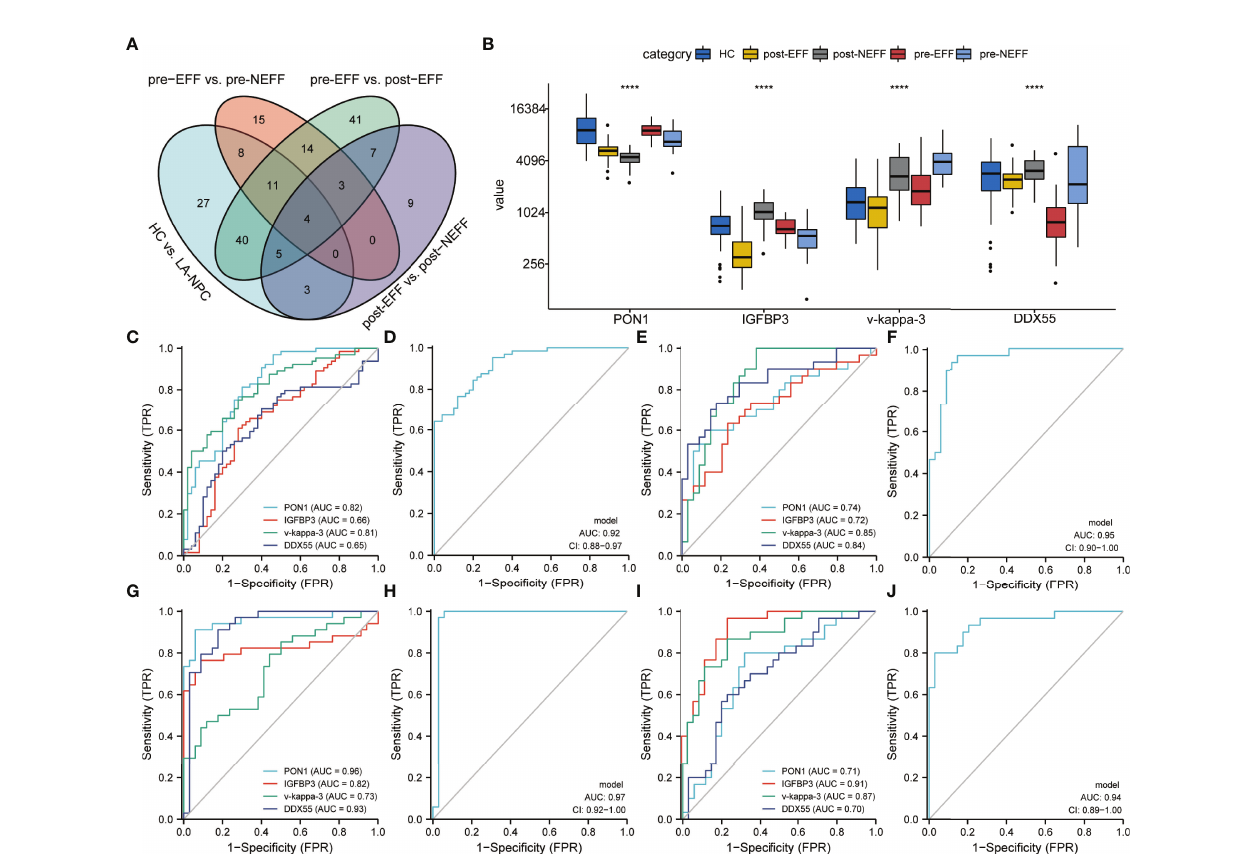
FIGURE 9 | Identi fi cation of candidate biomarkers. (A) Venn diagram showing the overlap of DEPs between the four compared datasets. (B) Relative protein abundances of PON1, IGFBP3, v-kappa-3 and DDX55. (C, D) ROC analysis of the four proteins and their co-constructed model for distinguishing between HC and LA-NPC groups. (E, F) ROC analysis of the four proteins and their co-constructed model for distinguishing between pre-EFF and pre-NEFF groups. (G, H) ROC analysis of the four proteins and their co-constructed model for distinguishing between pre-EFF and post-NEFF groups. (I, J) ROC analysis of the four proteins and their co-constructed model for distinguishing between post-EFF and post-NEFF groups. ****p <